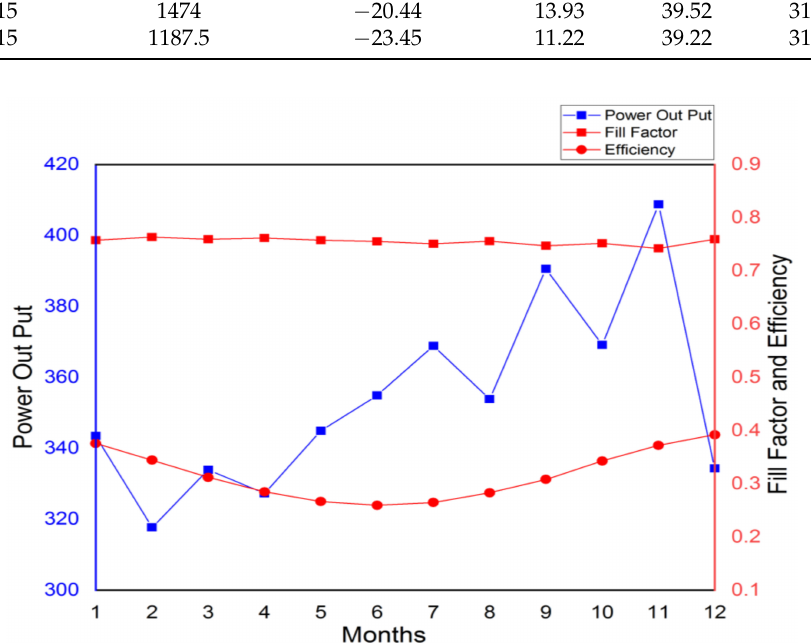
Figure 8. Power, efficiency, and FF at a 15 ◦ fixed tilt angle, by